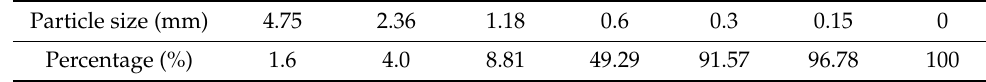
Table 2. Cumulative percentage retained of fine aggregates.